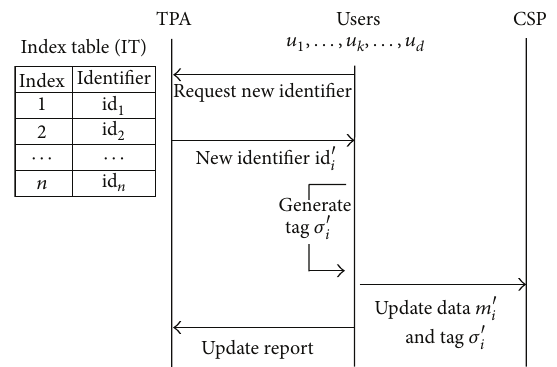
Figure 2: Data update flows when the only TPA manages an index table.